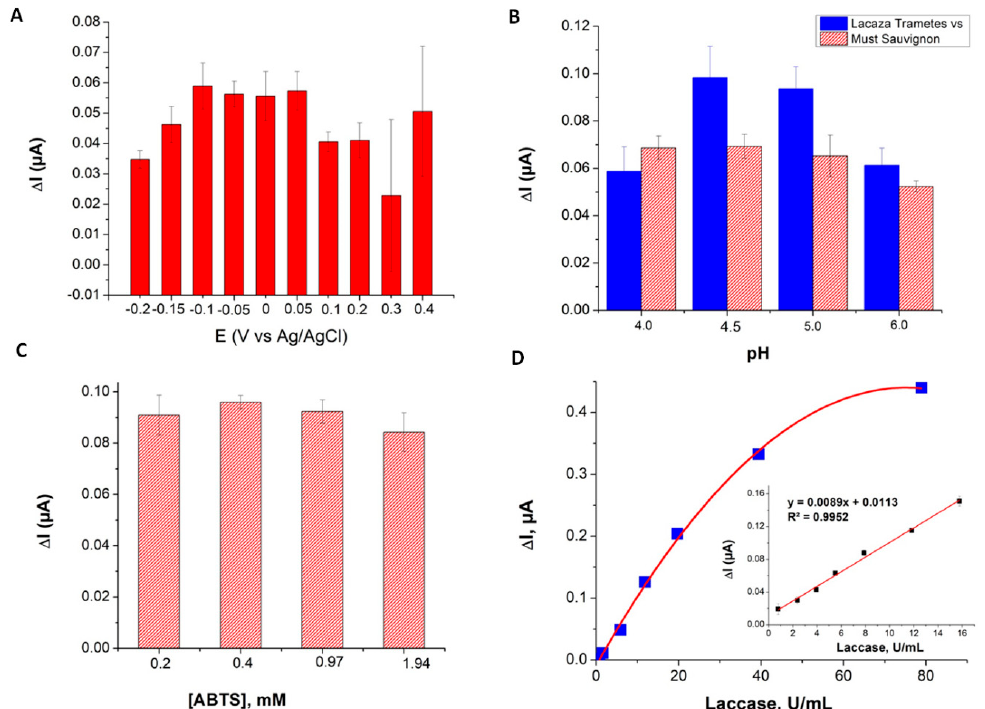
Figure 4. Optimization of the experimental parameters for the electrochemical assay of laccase using SPAuEs: ( A ) applied potential, ( B ) pH, ( C ) concentration of ABTS. ( D ) Typical calibration curve for the determination of laccase activity, showing in the inset the linear range of the